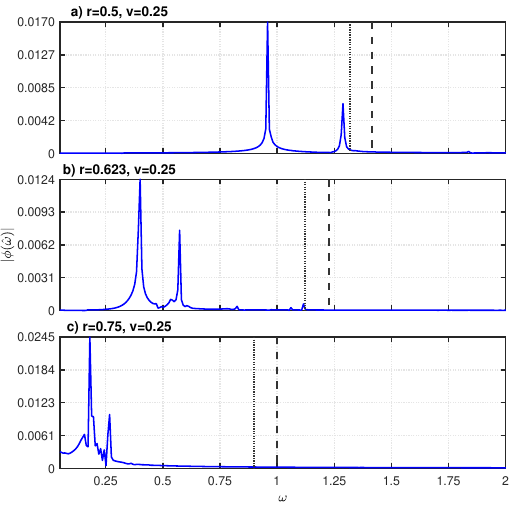
Figure 12 . Large kink-antikink collision: Fourier transform at the center of the thinnest small antikink-kink pair for 100 < t < 800. For all points we fixed v = 0 . 25. In each figure, the dashed line corresponds to the threshold of the continuum modes. The dotted line corresponds to the vibrational mode.